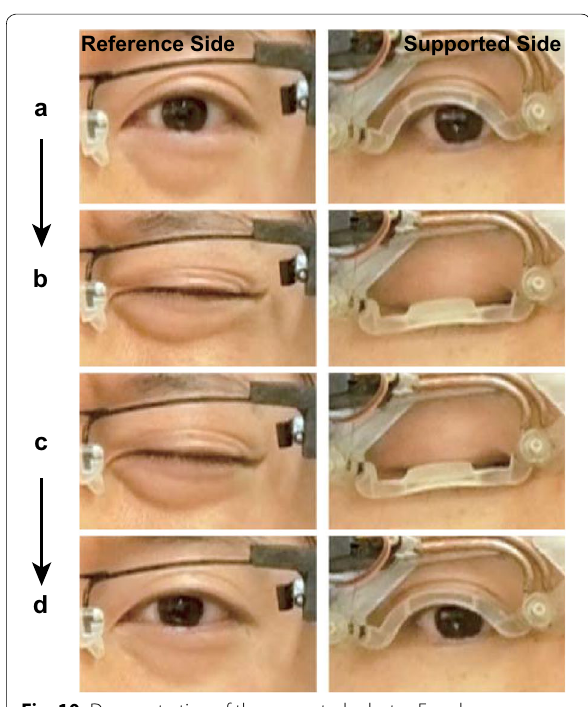
Fig. 10 Demonstration of the presented robot. a Eye closure detection, b completion of eyelid closure support, c detection of eye opening, and d completion of eyelid closure support. Each picture corresponds to the points in Fig.